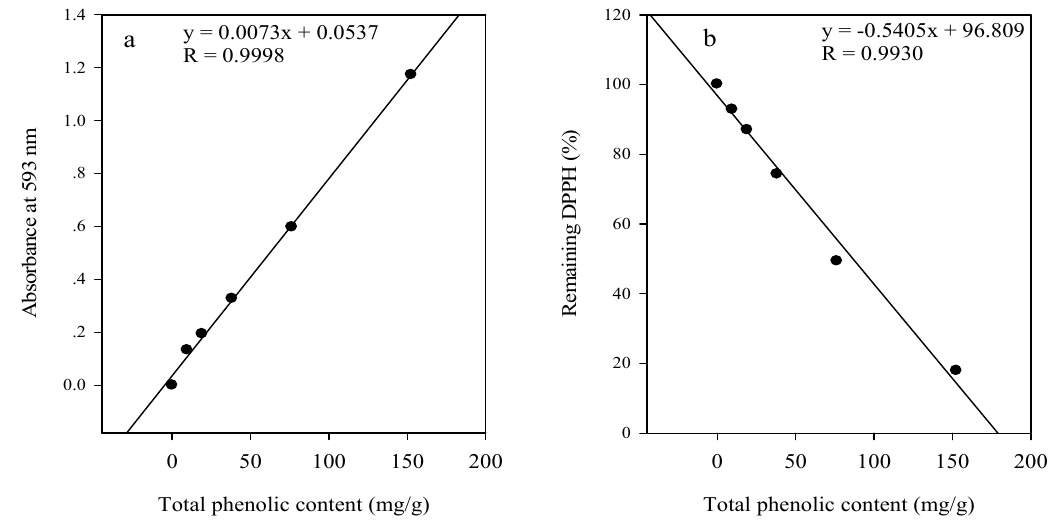
Figure 1. Relationships between the total phenolic content and the ferric reducing power (a); the total phenolic content and the free radical scavenging activity (b) of the methanolic extract (ME) of S . cumini .